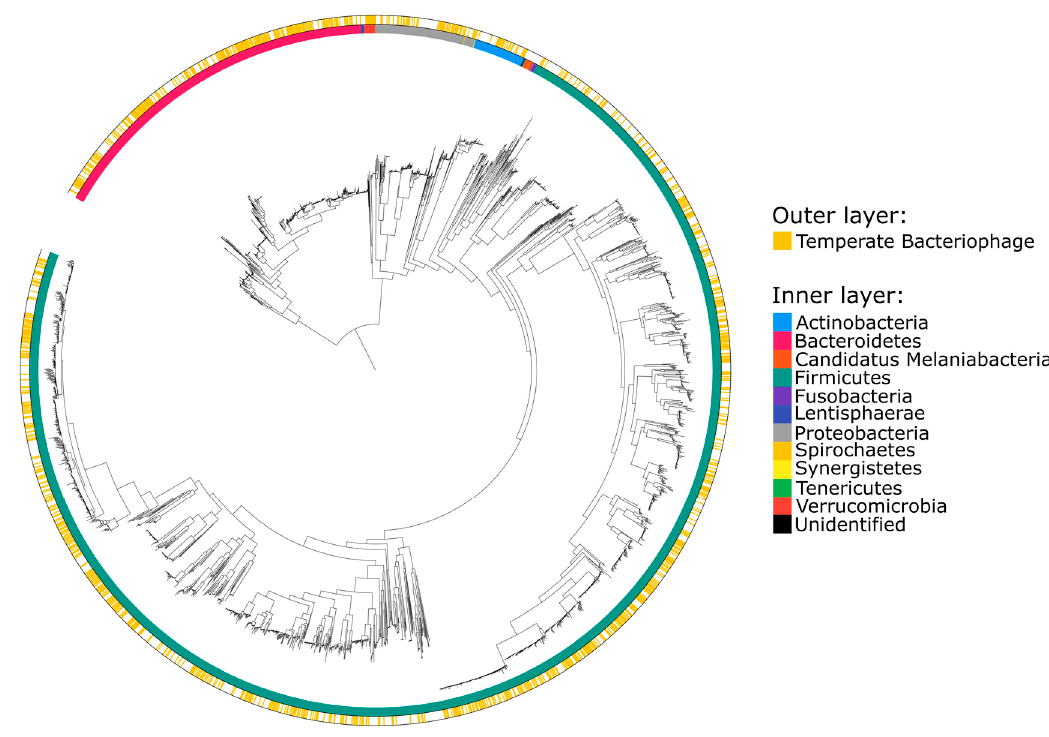
Figure 2. Phylogenetic tree based on a comprehensive collection of reconstructed bacterial genomes. The inner layer colors correspond to the bacterial phyla represented at the tip of each branch. The outer layer indicates bacteria associated with functional temperate bacteriophages.